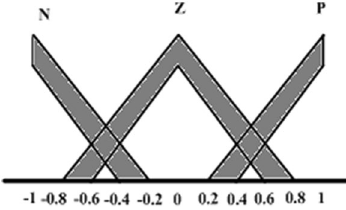
Fig. 8 MFs of the speed error for interval type-2